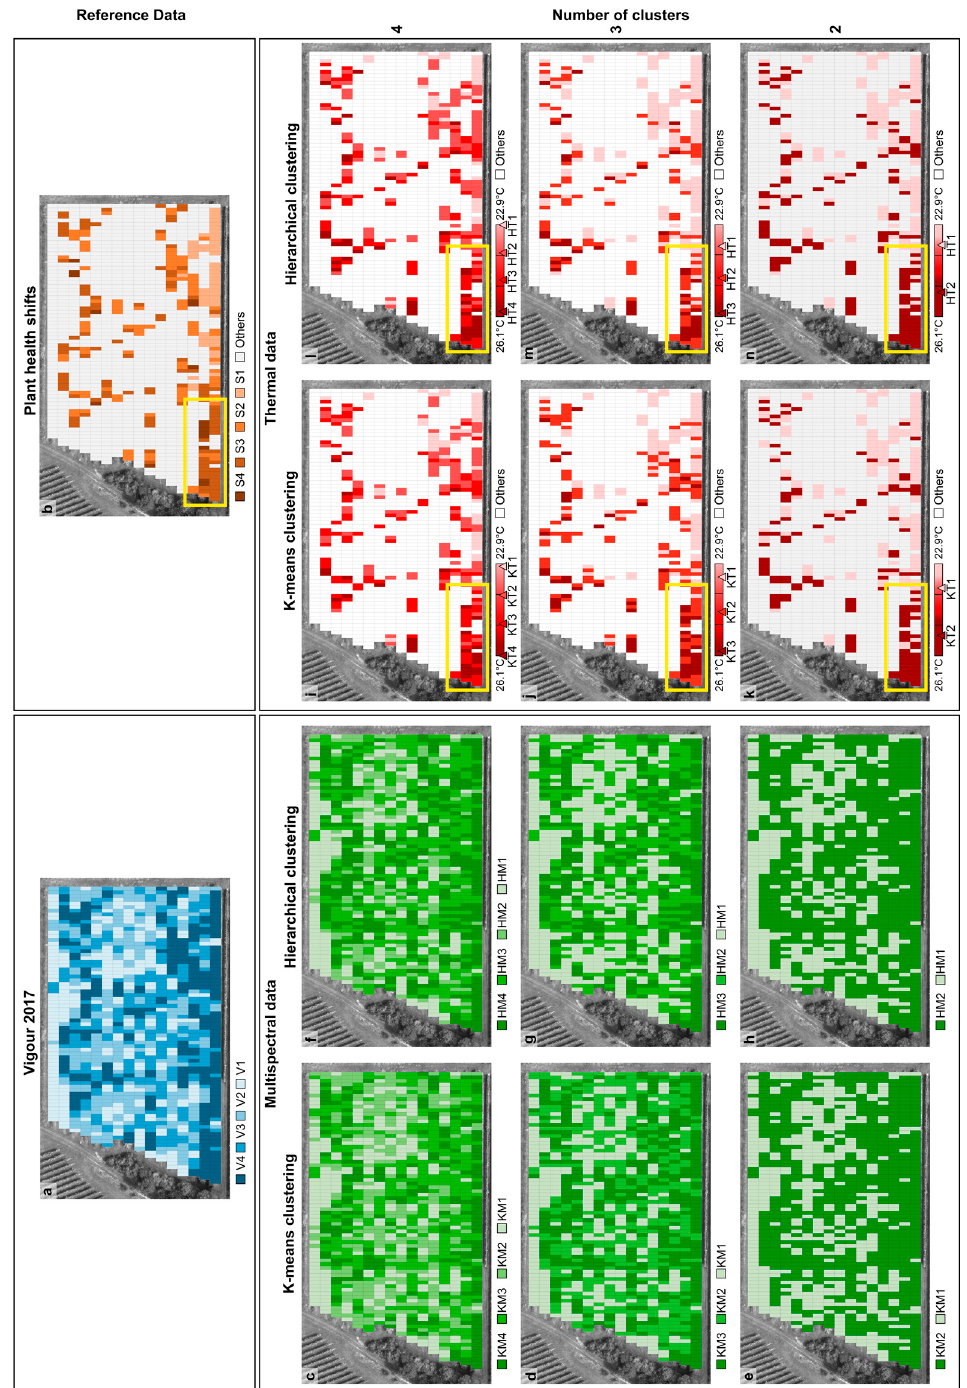
Figure 3. Spatial distribution of the results obtained after clustering and the references used for the interpretation. ( a ) In the blue scale, expert assessment ratings for the vigour classes (V4 high, V3 medium, V2 diseased, V1 dead). ( b ) In the brown scale, plant health shifts between 2017 and 2018 (S1 asymptomatic plants that preserved high vigour, S2 asymptomatic but weakened plants, S3 diseased plants but still alive, S4 plants that died in 2018). In the green scale, K-means ( c–e ) and hierarchical ( f–g ) clustering derived from multispectral bands. In the red scale, K-means ( i–k ) and hierarchical ( l– n ) clusters resulting from the analysis of thermal images: triangles indicate the temperature of the clusters’ centres. In ( b ) and ( i–n ) white represents plants that were not highly vigorous in 2017 and were therefore removed from the plant health shift analysis. Yellow rectangles in ( b ) and ( f - h ) identify the hottest area within the orchard that happened to have the highest disease incidence in 2018.